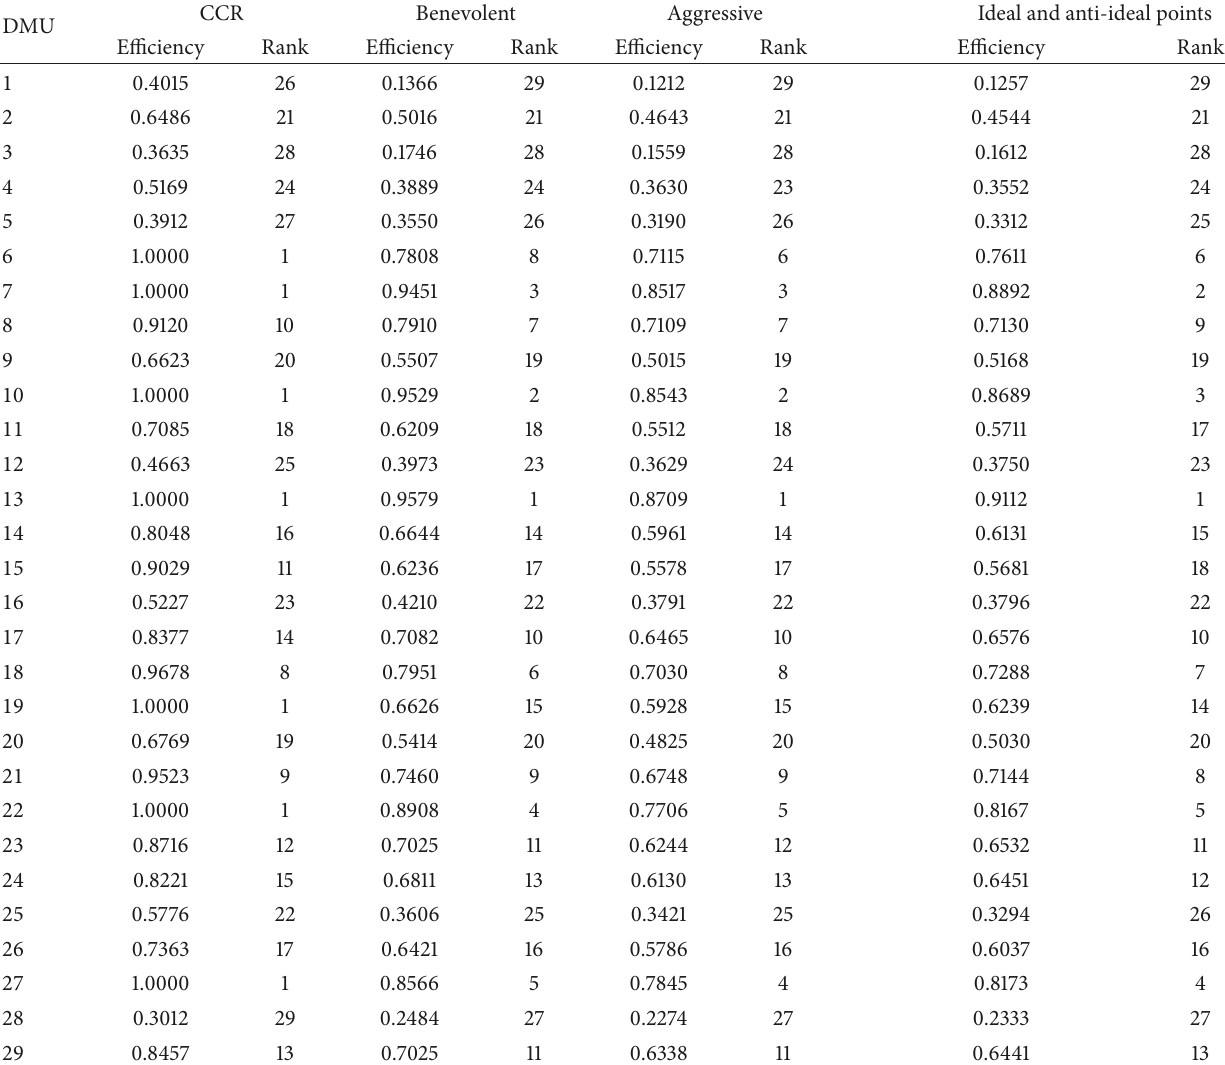
Table 5: Efficiency rating and rank for the twenty-nine DMUs.